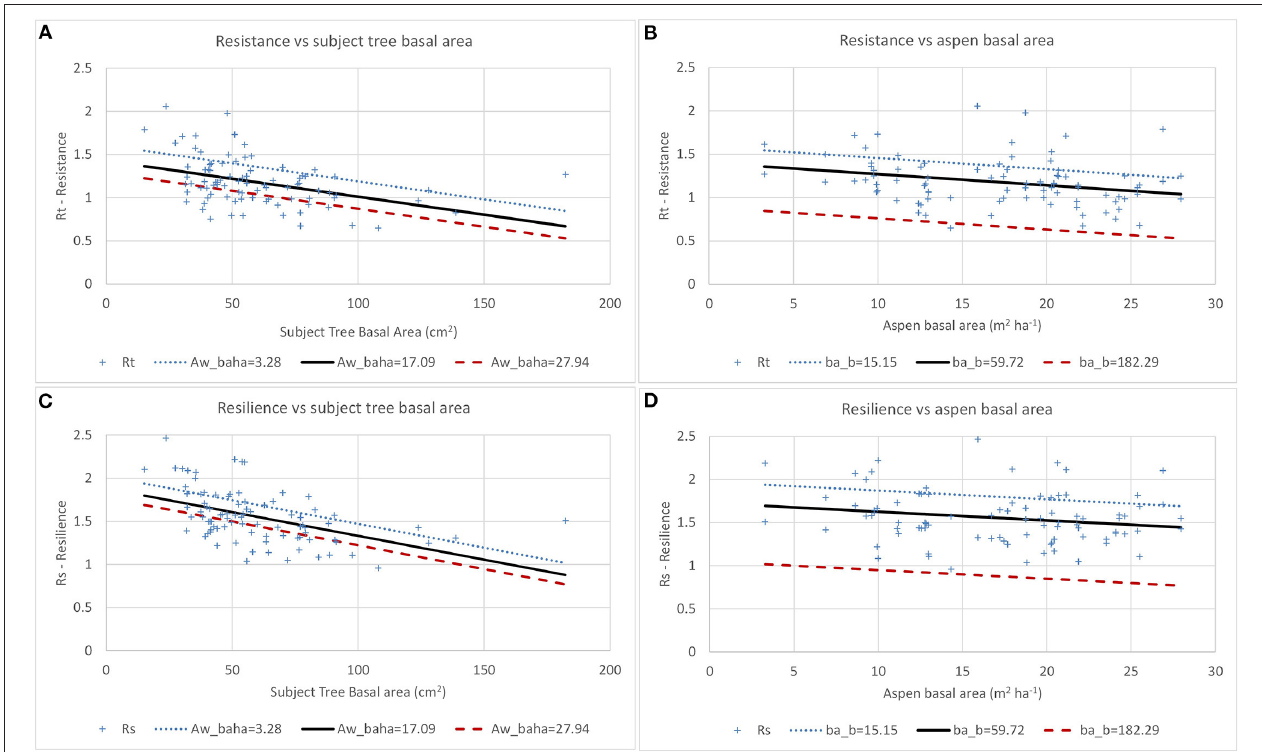
FIGURE 6 | Effects of tree size (A,C) and aspen basal area (B,D) on aspen resistance (Rt) and resilience (Rs) in 2003. + Shows data points and lines show predicted values. Aw_baha = aspen basal area (m 2 ha − 1 ) and ba_b = initial tree size (m 2